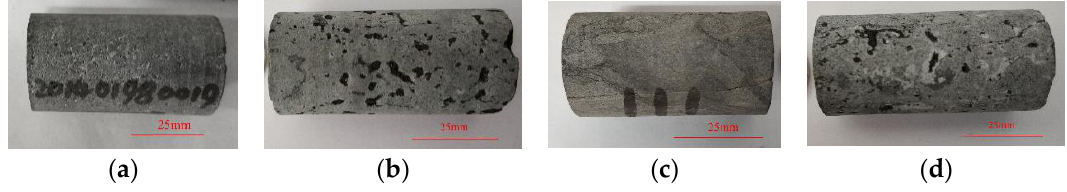
Figure 6. Cores with different pore structures: ( a ) pore type, Gaoshi-7 well, 4834.41 m; ( b ) cavity type, Moxi-56 well, 4965.83 m; ( c ) fracture-pore type, Moxi-107 well, 4828.86 m; ( d ) fracture-cavity type, Moxi-56 well, 4964.46 m.